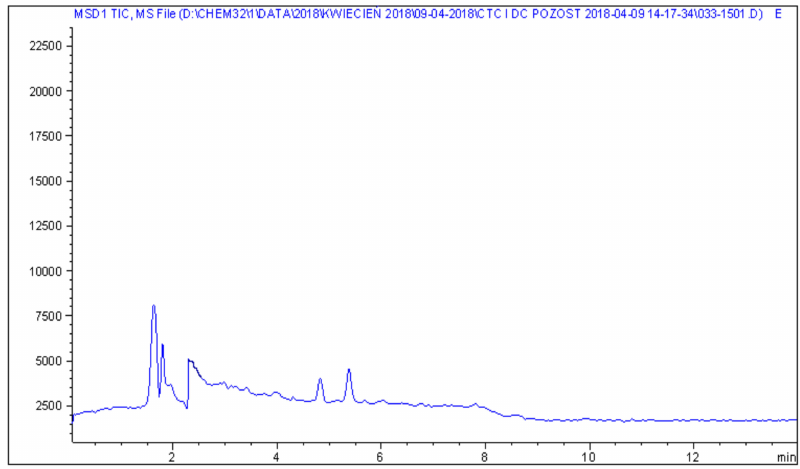
Figure 2. LC − MS chromatogram of a blank feed